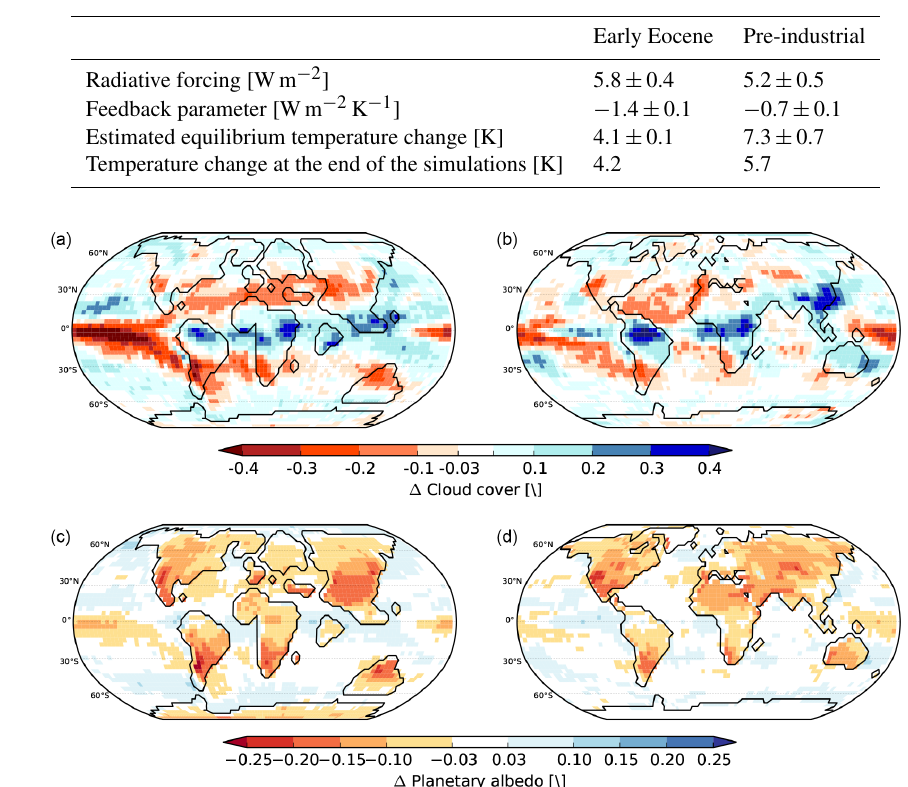
Figure 6. Difference in cloud cover and planetary albedo between the forest world and the bright desert world averaged over the first year of the simulations. Differences in planetary albedo result from differences in surface albedo and in cloud cover. (a, c) show the differences for the early Eocene climate and (b, d) for the pre-industrial climate.